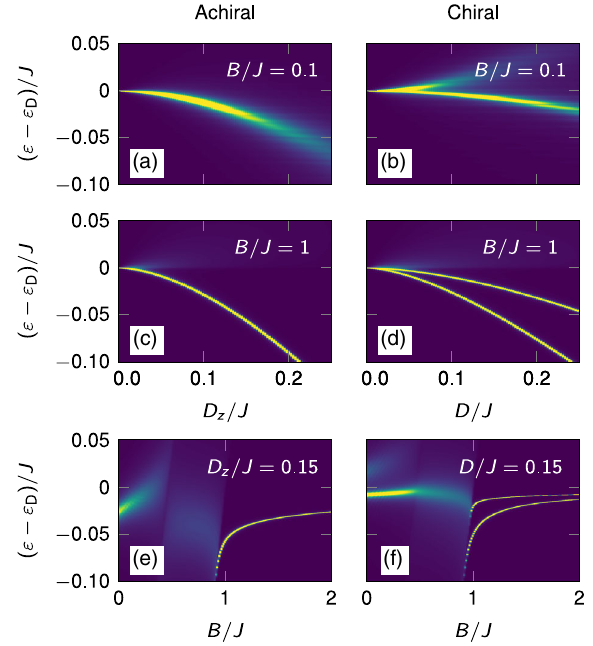
ε Þ at the K point as a FIG. 5. Magnonic spectral function A K ð function of DMI D and D and magnetic field B for the achiral z (left) and chiral (right) magnets, respectively. Dark blue (bright ε Þ ; S ¼ 1 . (a,b) DMI yellow) color indicates zero (maximal) A K ð ε Þ at B=J ¼ 0 . 1 and (c,d) at B=J ¼ 1 . (e,f) dependence of A K ð ε Þ for (e) D =J ¼ 0 . 15 and Magnetic field dependence of A K ð z (f) D=J ¼ 0 . 15 . In the chiral magnet (right column), a finite Dirac cone mass is witnessed by the splitting of the quasiparticle peak.